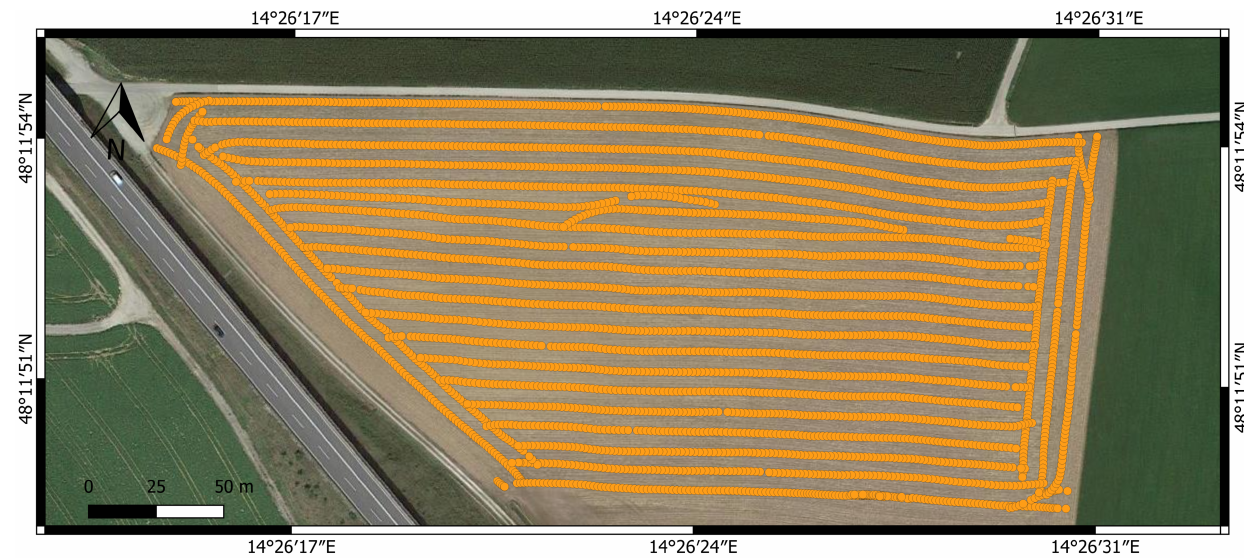
Figure 3. Original data from the yield monitor device in the points form.